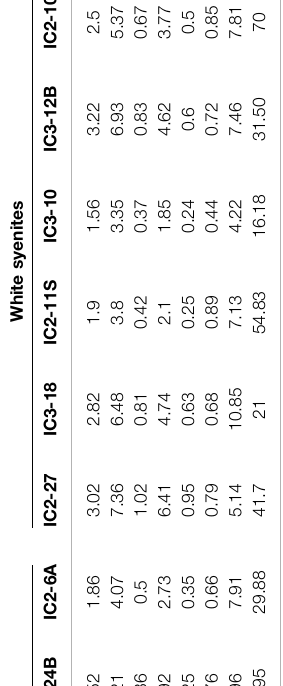
( Table 1 ; Figure 6B ). Nb is fractionated from Ta (Nb/Ta (cid:1) 0.56 – 17.35) with high fractionation and negative anomaly in Zr-Hf (Zr/Hf (cid:1) 20.52 – 55.77). Si-rich carbonatite REE patterns are similar to those of Si- poor carbonatites. They are enriched in 2,633 to 7,551 times chondrite with a slight negative anomaly in Eu (Eu/Eu* (cid:1) 0.69 to 0.82; Figure 6C ) and La N /Yb N ratio from 88 to 145. The concentrations of LILE and high- fi eld-strength elements (HFSEs) in Si-rich carbonatites are higher than in Si-poor carbonatites (0.31 – 1.46 ppm Cs, 29.79 – 183 ppm Rb, 559 – 3,104 ppm Ba) with high contents in U and Th ( Table 1 ; Figure 6D ) and Nb-Ta and Zr-Hf fractionation (Zr/Hf (cid:1) 22.28 – 59.20, Nb/Ta (cid:1) 3.39 – 11.14). Syenites Red syenites are potassic (K/Na (cid:1) 1.46 – 5.44) with high silica and high alkali (Na 2 O + K 2 O) contents ranging from 57.49 to 71.67 wt.% and 6.56 to 12.40 wt.%, respectively ( Figure 4 ), and 1.80 to 12.78 wt.% CaO. MgO and FeO content ranges from 0.53 to 7.68 wt.% and 1.76 to 4.22 wt.%, respectively, with Mg# (cid:1) 0.54 – 0.87 ( Figure 5 ). White syenites have alkali contents (K/Na (cid:1) 0.19 – 7.51; Na 2 O + K 2 O (cid:1) 4.23 – 12.77 wt.%) ( Figure 4 ) similar to red syenites and 52.75 to 58.47 wt.% SiO 2 , 6.89 to 14.26 wt.% CaO, 0.18 to 2.99 wt.% MgO (Mg# (cid:1) 0.40 – 0.72), and 0.69 to 7.01 wt.% FeO ( Figure 5 ). We note that one wollastonite-rich white syenite has very low alkali content (2.65 wt.% Na 2 O + K 2 O) and very high CaO (33.87 wt.%; Table 1 , IC2-27, Figure 2F ). Red syenites are LREE-enriched compared to HREE on a chondrite-normalized plot (573 – 1,100 times; La N /Yb N (cid:1) 17.61 – 90.44) with negative Eu anomaly (Eu/Eu* (cid:1) 0.47 – 0.75) ( Figure 6E ). In comparison with carbonatites, they have higher LILE concentrations (0.22 – 2.82 ppm Cs, 138 – 388 ppm Rb, 698 – 4,198 ppm Ba), with negative anomalies in Nb-Ta and Zr-Hf (Zr/Hf (cid:1) 13.47 – 29.88, Nb/Ta (cid:1) 0.16 – 21.51; Figure 6F ). REE white syenite patterns are similar to red syenite patterns, with LREE enrichment compared to HREE (739 – 1862 times; La (cid:1) 35 – 131.25; Figure 6G ). They have (cid:1) 175 – 441 ppm; La N /Yb N variable concentrations in Cs (0.09 – 2.71 ppm Cs) and Rb